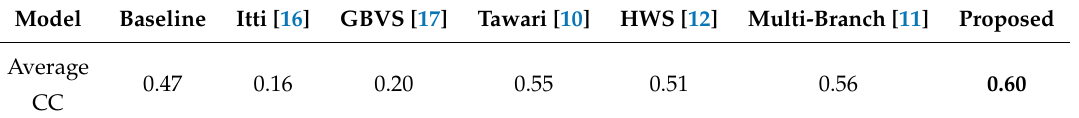
Table 1. Performance of the proposed model against other models in terms of CC in (2). Please note that the score of HWS model was measured from the network that trained using the selected 200 ten-second long video clips from the DR(eye)VE dataset [11]. The model was fine-tuned with their own dataset proposed in [12] and tested for the DR(eye)VE dataset. Except for the model, other networks were trained and tested using the DR(eye)VE dataset.